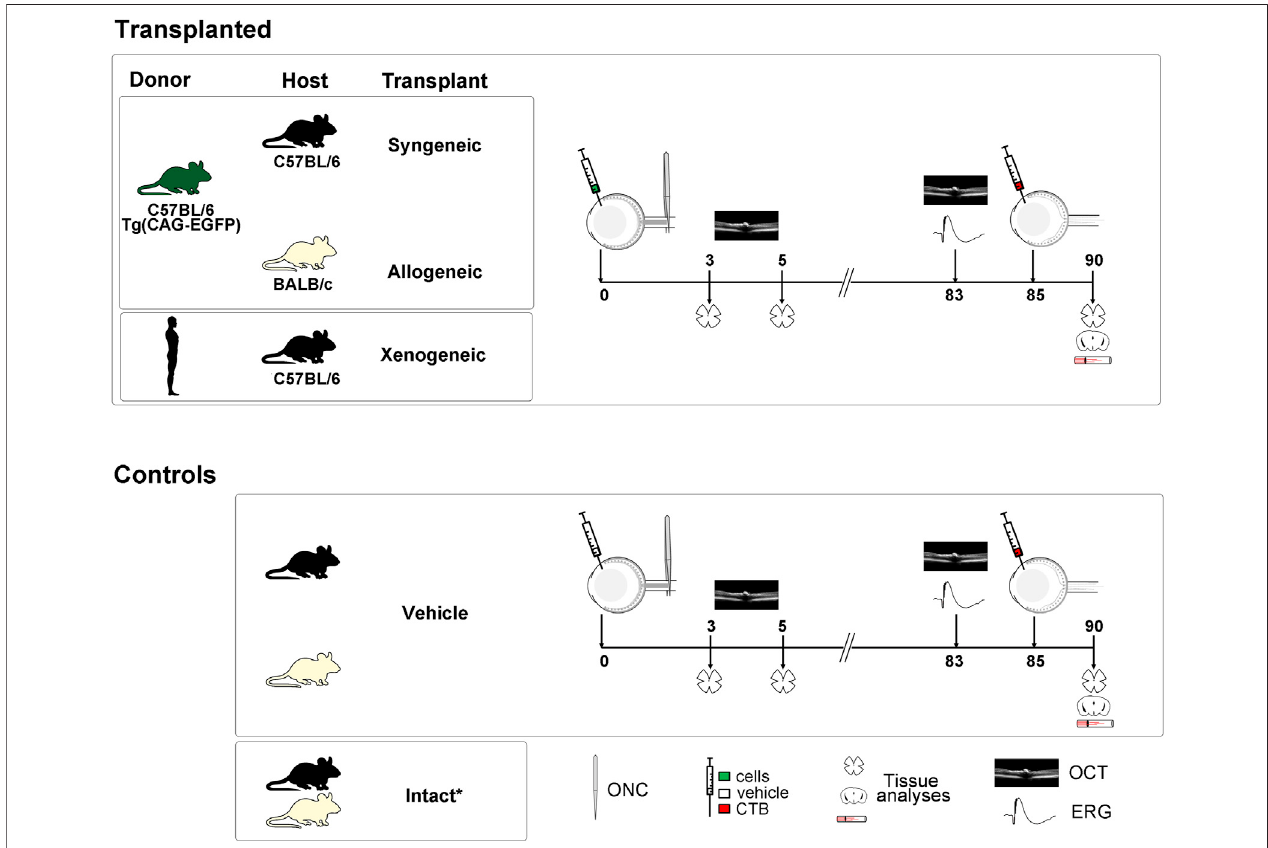
FIGURE 1 | Experimental design. *Controls: intact animals for anatomy and the right eyes for SD-OCT and ERG. Human and dark green mouse silhouettes: donors, Black and off-white mouse silhouettes: recipients and controls. Human and mouse drawings are modi fi ed from Vecteezy.com.